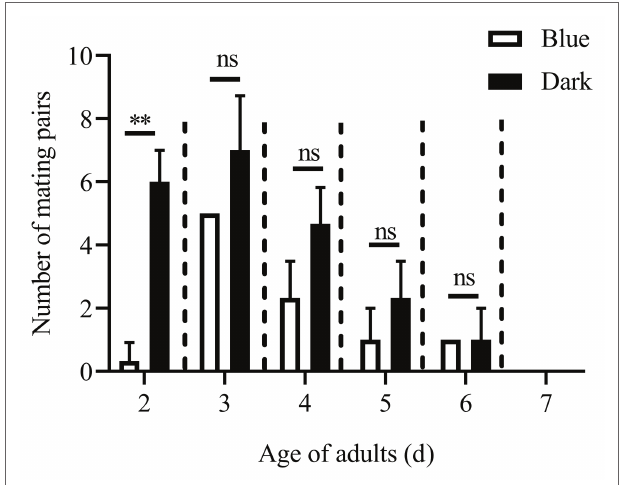
TABLE 3 | Oviposition of C. punctiferalis under red light and dark conditions during scotophase. Lights Age of adults (d) Eggs / ♀ /d 2 Red light